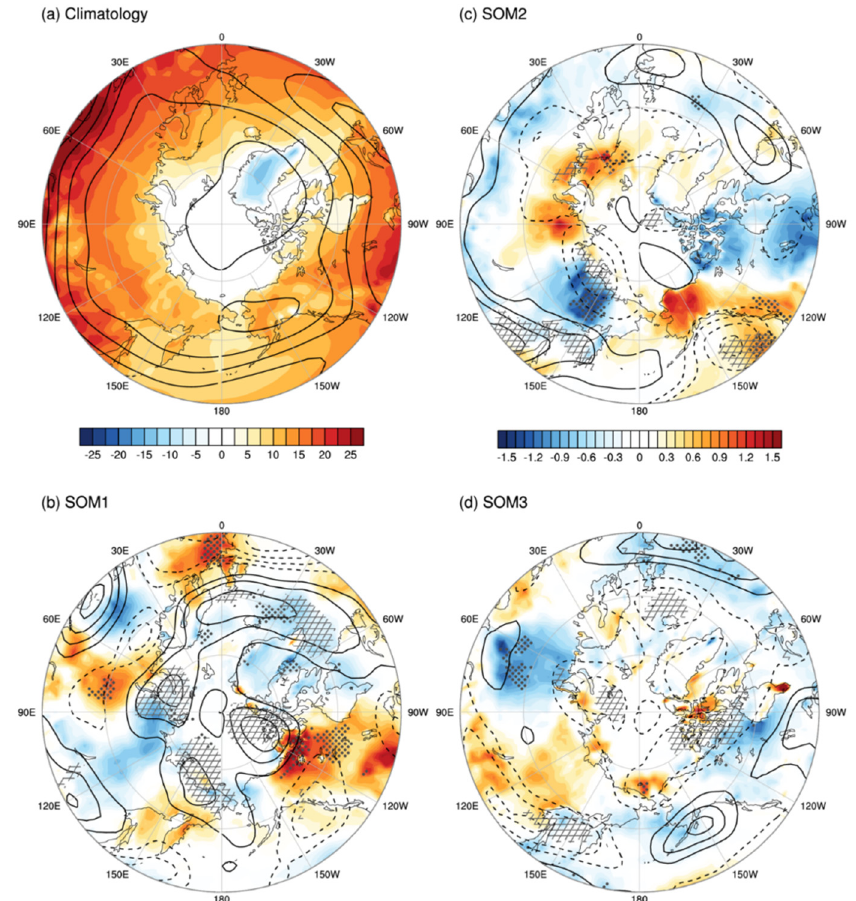
Figure 4. Climatological map of skin temperature (T s ) (shading, °C) and 200-hPa zonal wind (U200) (contour, m s − 1 ) for June–July–August (JJA) in the period from 1979 to 2017 ( a ) and their composite anomalies in the first five years with the highest occurrence frequencies selected from the detrended time series of each SOM ( b – d ). The dots denote the grids, where the anomaly was observed to be statistically significant at a 10% level by the Monte Carlo test.